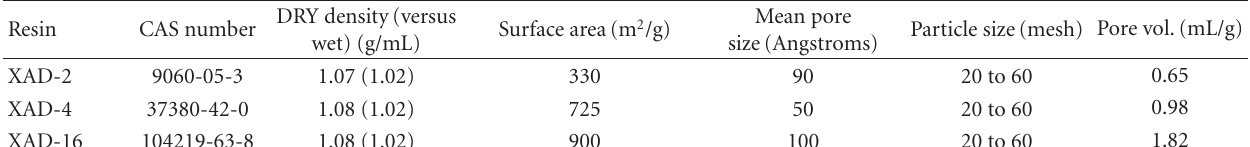
Table 1: Physicochemical properties of Amberlite resins [6].